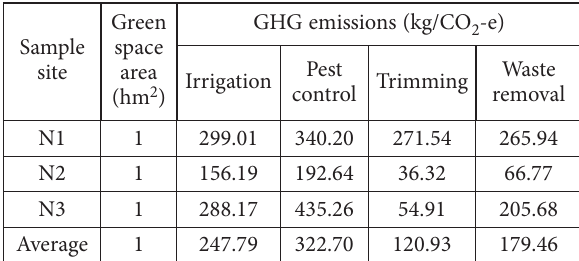
Table 8. GHG emissions from the various maintenance tasks in the natural cemetery green space